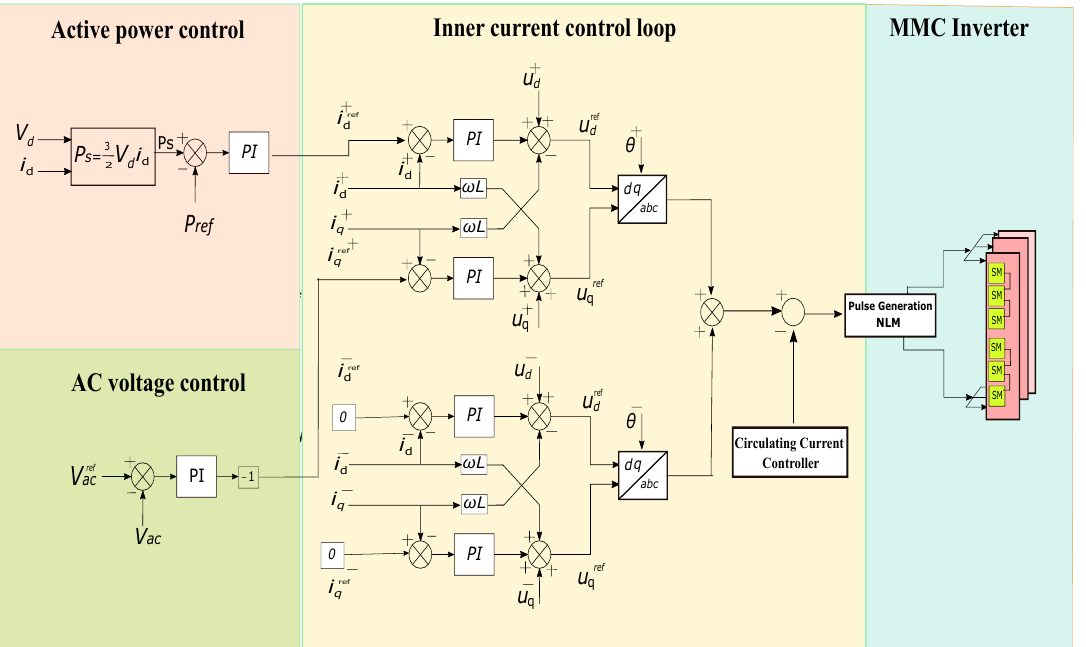
Figure 15. Outer and inner control loop for MMC-inverter. The PI controller is tuned at k p = 0.1193 and k i = 55.891 to control the AC side active power of MMC-inverter. Simulation results for active power control of MMC-inverter are shown in Figure 16. This shows that the load is receiving healthy nominal power. Circulating current suppression control is an outer loop control that effectively suppresses the problematic AC component of circulating differential current in modular multilevel converter arms. The controller designed for circulating current suppression control of the MMC-rectifier and the MMC-inverter is the same as that shown in Figure 12. The circulating current controller feeds its reference signals to the inner current loop (ICL). The PI controller is tuned at k p = 1 and k i = 5. A simulation for the circulating current suppression controller is shown in Figure